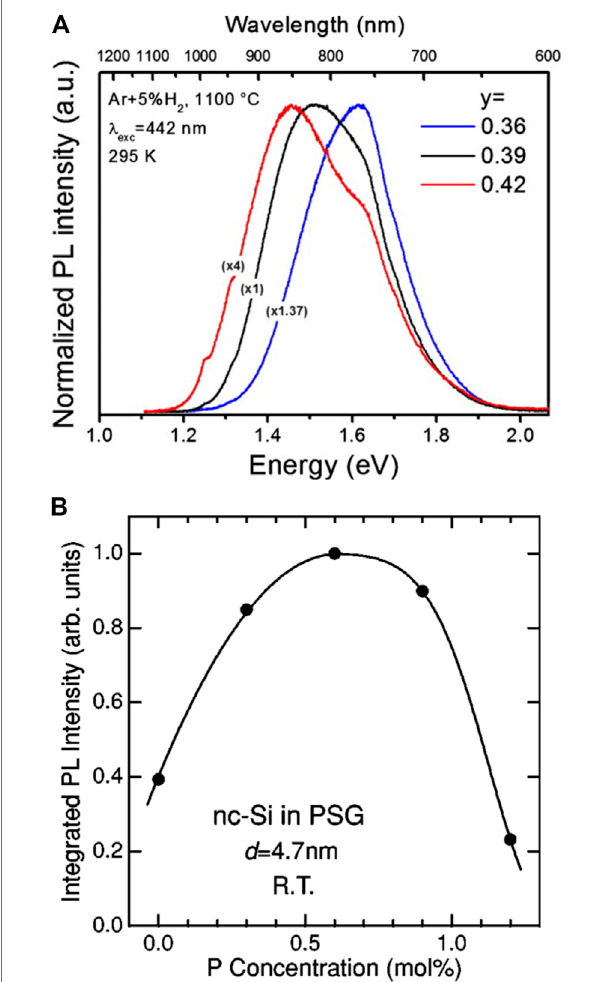
FIGURE 3 | (A) Room-temperature PL spectra for annealed Si y O 1-y at 1,100 ° C in a forming atmosphere with different y, reprinted with permission from Borrero-González et al. (2010). Copyright 2010 American Institute of Physics. (B) Integrated PL intensity of P-doped SiNCs as a function of P concentration, reprinted with permission from Mimura et al. (2000). Copyright 2000 American Physical Society.